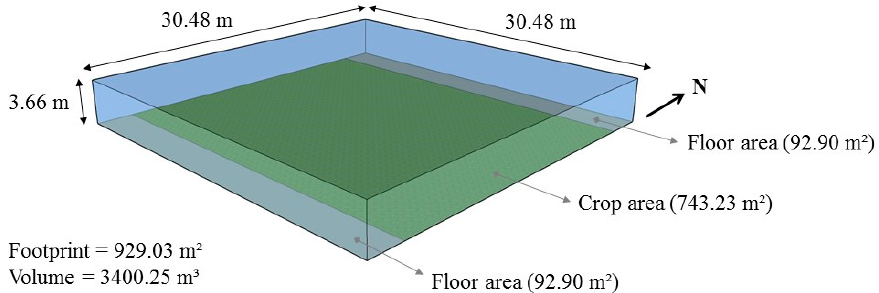
Figure 1. Schematic showing the modeled greenhouse.